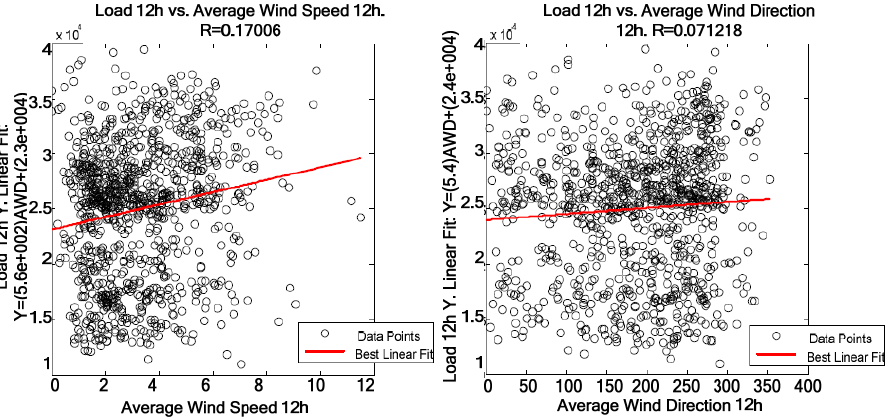
Figure 8. Correlation between average wind speed + average wind direction and electric power consumption at 12 h.